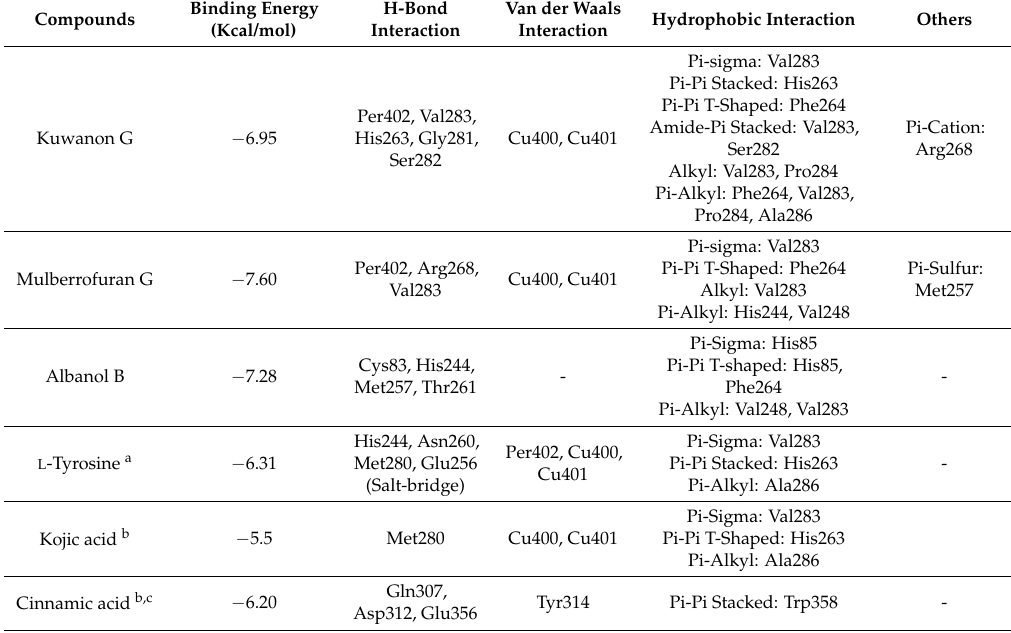
Table 2. Molecular interaction of oxy-form mushroom tyrosinase active site with three compounds as well as positive